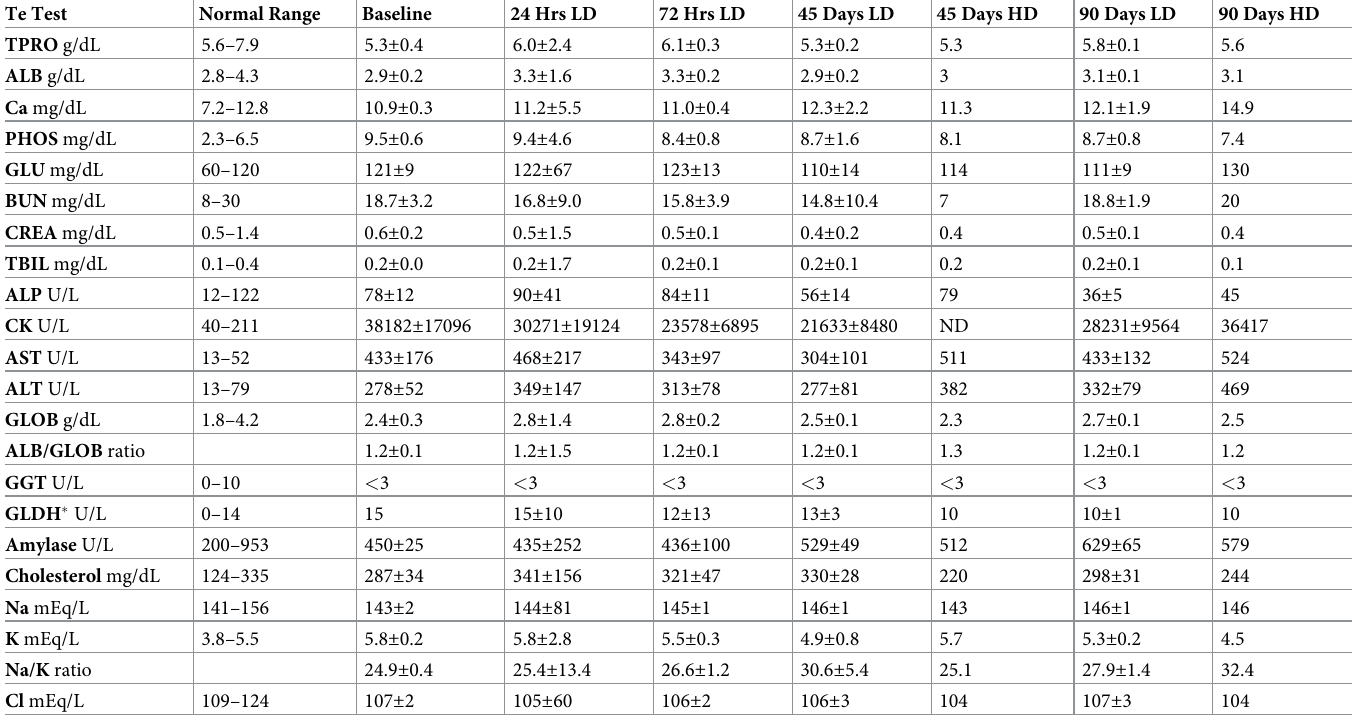
Table 2. Serum chemistry